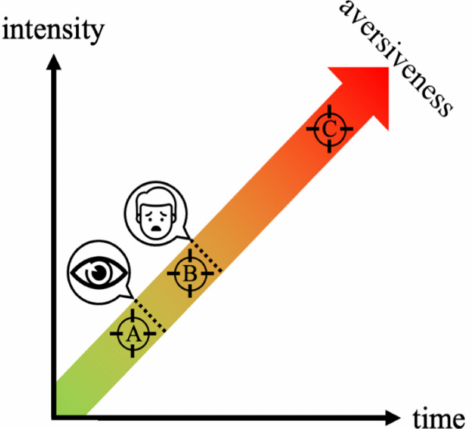
Figure 1. Time duration and intensity (perceptual and/or emotional) of phobic stimuli affect their emergence to consciousness and the acceptability of their exposure. Some authors [10,20] propose to shift the target of exposure therapies from clearly-visible and aversive stimuli (C) to perceptually- subliminal ones (A) to increase access and adherence to treatment. Based on studies assessing stimulus visibility trial-by-trial [6], it seems unlikely that all very brief (e.g., 30 ms [13]) stimuli were successfully masked (i.e., perceptually-subliminal); however, even those that were actually detected were still unable to elicit the expected fear reaction. This mismatch between the detection of phobic stimuli and the onset of the related emotional reaction would make these stimuli emotionally subliminal (B): this new class of stimuli could represent the best compromise between acceptability and efficacy of the